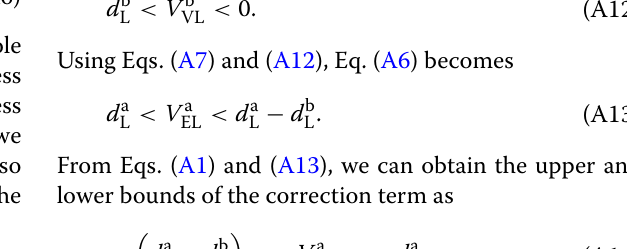
When we use the same values as above, the range of the correction term is from Because the elastic deformation should be dominant in the long-wavelength component, (cid:31) correction term would be closer to